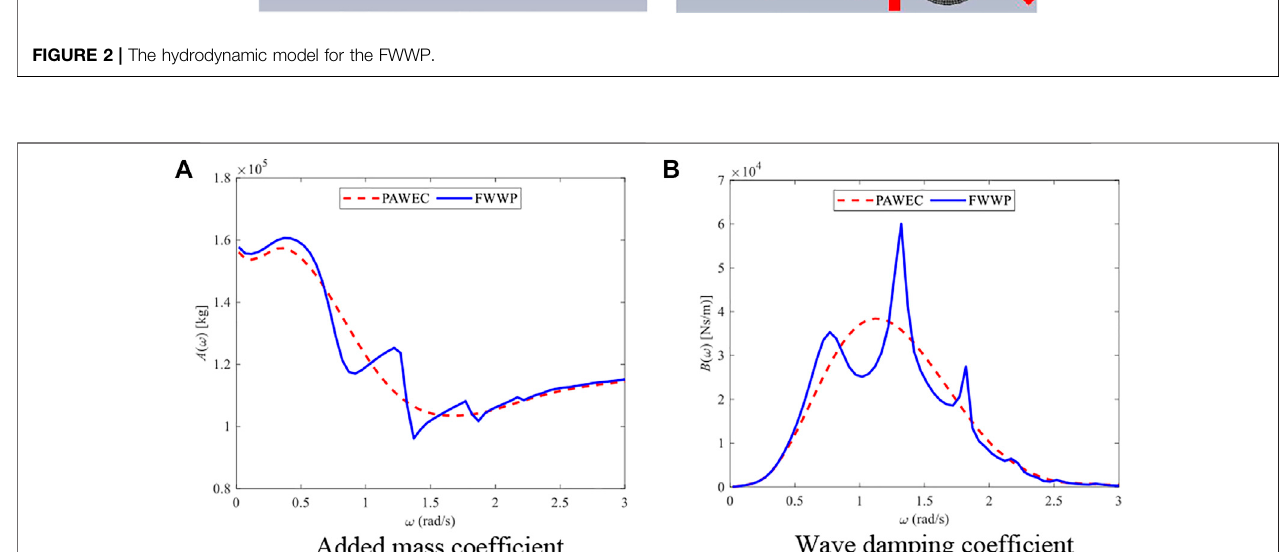
FIGURE 3 | The comparison of heave radiation coef fi cients for the fl oater. (A) Added mass coef fi cient. (B) Wave damping coef fi cient.